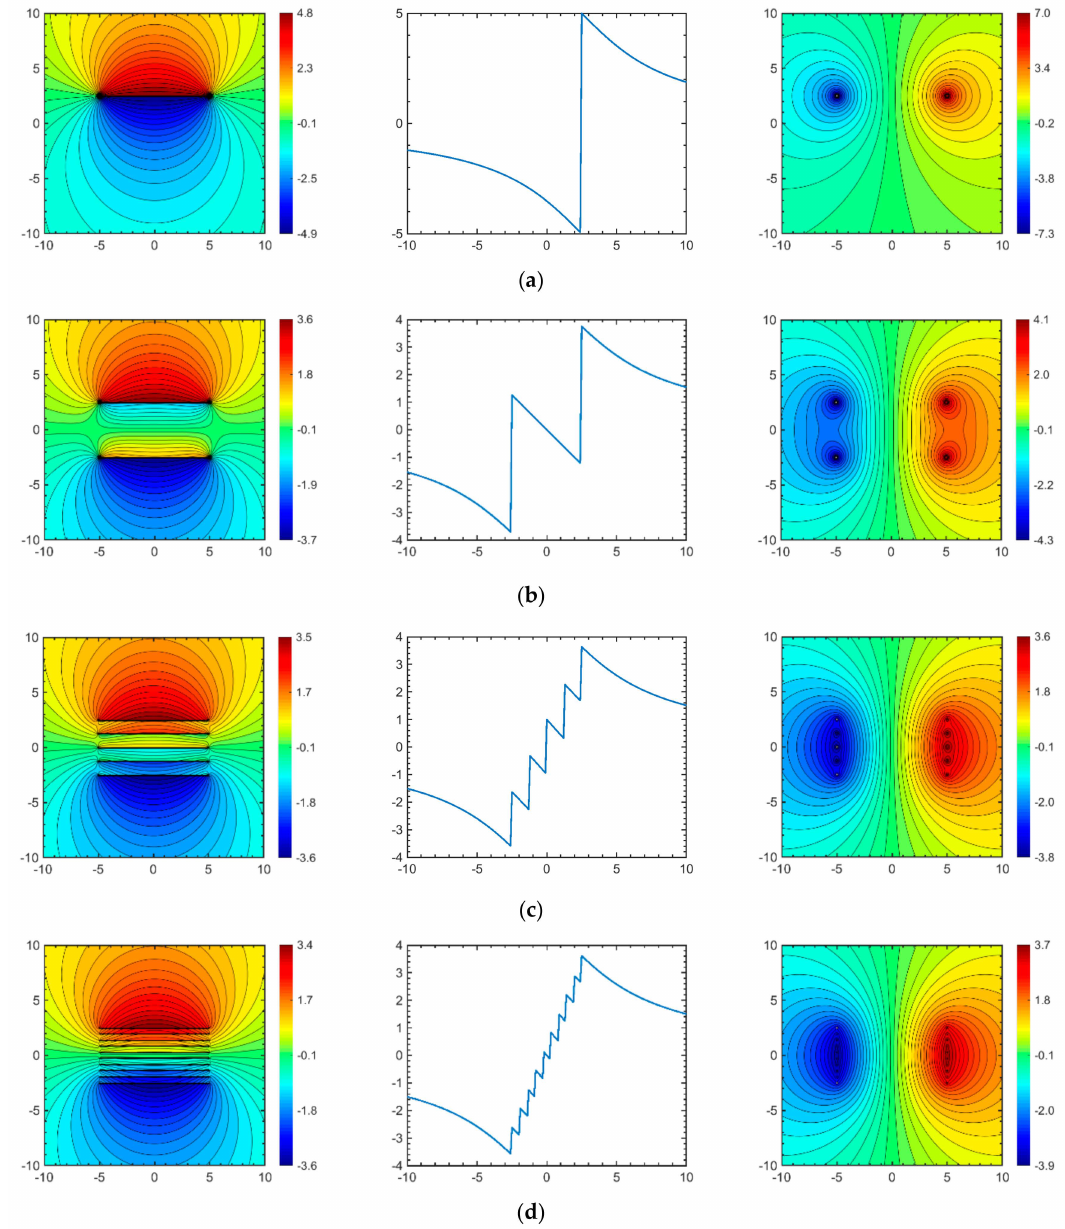
Figure 13. ( a – d ) Superposition of discrete line doublets, with respectively 1, 2, 5 and 10 line doublets. Plots show map of potential function solution (left images), vertical profile along central part of potential field at x = 0 and y = ± 10, with value jumps across the branch cuts (central images), and stream function solutions (right images). Cumulative strength of line doublets in each case is 100 m 3 · s − 1 , length is 10 m each, oriented at 0 ◦